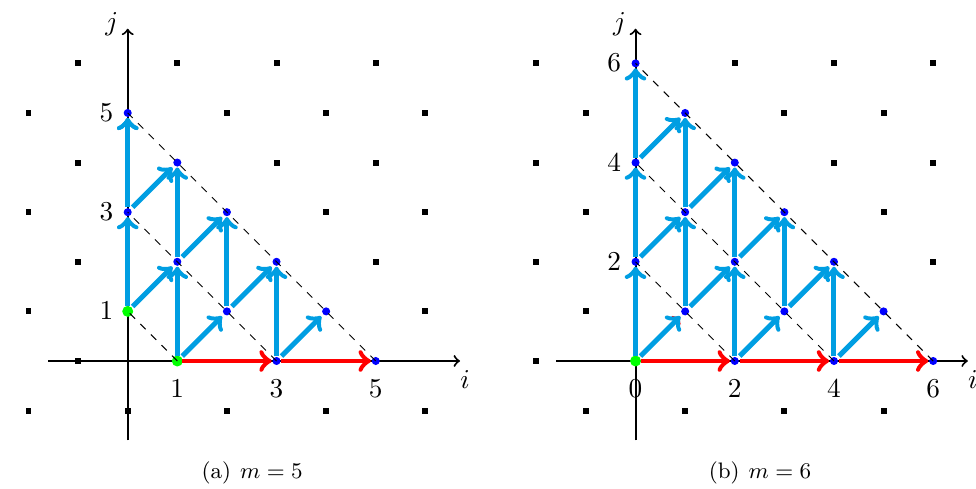
Figure 2 . Algorithm for the calculation of the expansion coefficients of tadpole coefficients of a tensor triangle integral with rank m = 5 and m = 6 . Here the each point ( i, j ) represents an expansion coefficient c (5) and c (6) . The points represented by black squares are the zero expansion i,j i,j coefficients (we don’t draw those expansion coefficients with i + j = even for m = 5 and i + j = odd for m = 6 , for they all vanish according to the definition) while the points represented by blue or green circles are the unknown expansion coefficients we need to calculate. The red thick arrow represents the first one of the recurrence relations (3.27) and the cyan thick arrow represents the second one of the recurrence relations